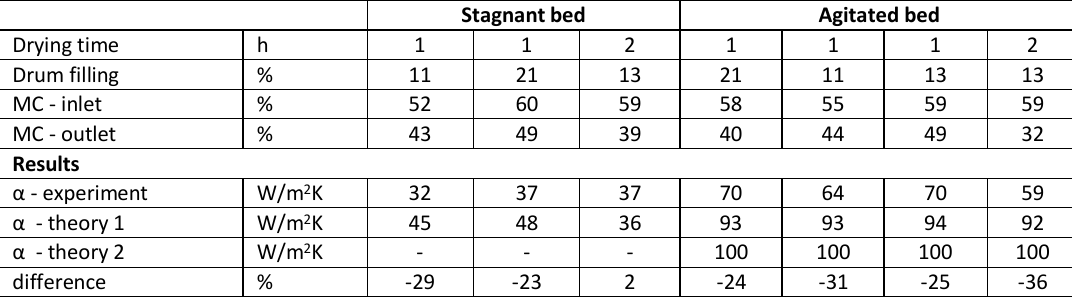
Table 1. Comparison of the theoretical and experimental results of the overall